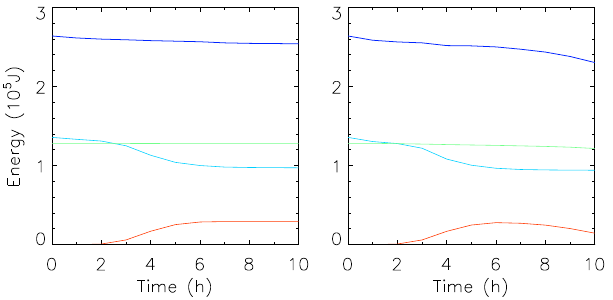
Fig. 5. Evolution of wave energies in propagation and interaction for cases 1 (left) and 2 (right). The cyan, green and red lines denote the energies of waves 1–3, respectively; and the blue line denotes their total energy.